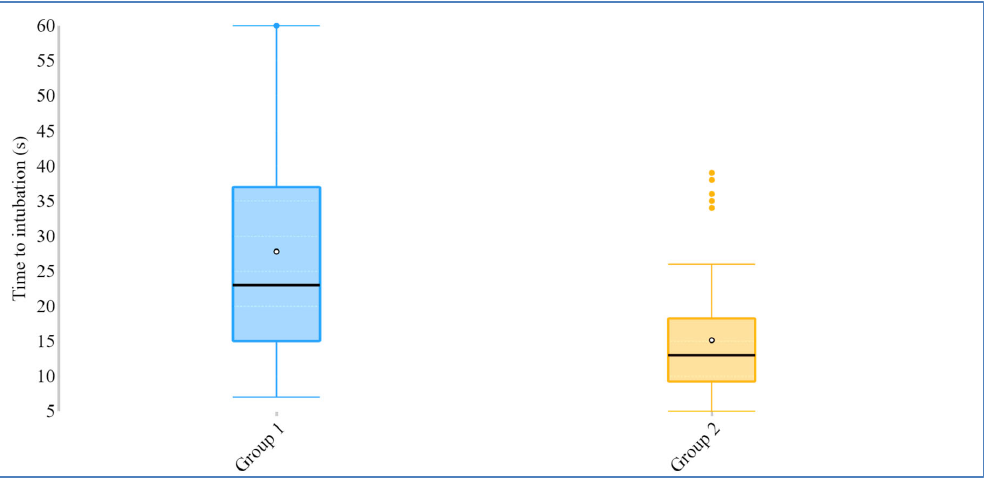
Figure 3. Box plot of the primary outcome—time to intubation. Group 1: non-channeled blade; group 2: channeled blade.